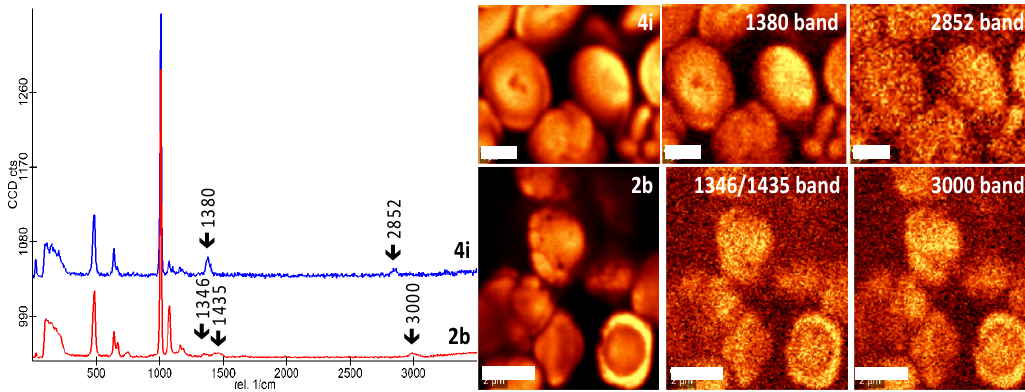
Figure 4. Raman spectra of samples 4i and 2b precipitated in solutions with organic compounds. Scales on the 4i images are 1 µm, and scales on the 2b images are 2 µm.